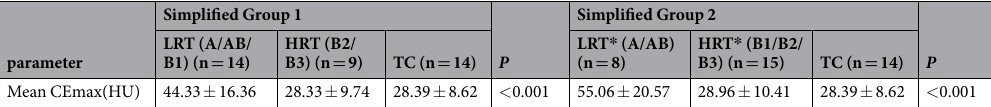
Table 3. The mean CEmax values in Simplified Groups 1 and 2 of 37 TETs. CEmax, the maximal contrast- enhanced range. TC, thymic carcinoma.